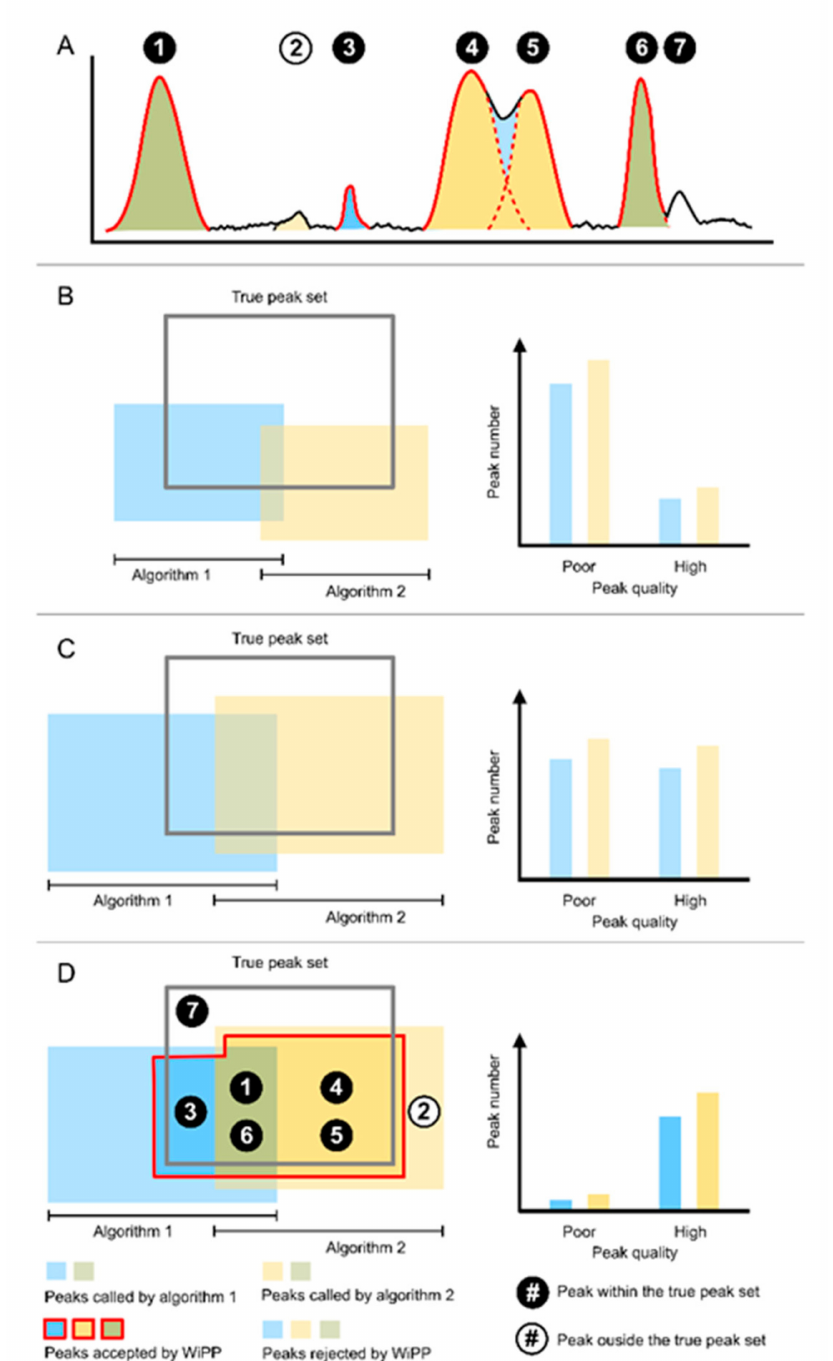
Figure 3. Schematic representation of the peak sets. ( A ) Chromatographic representation of peaks detected by the two peak picking algorithms accepted or rejected by WiPP. An individual ID is assigned to each peak. Peak 4 and 5 are erroneously detected by algorithm 1 as one single merged peak, hence the light blue colour between the distinct peaks properly detected by algorithm 2. ( B ) Peak called by peak picking algorithm 1 and 2 compared to the true peak set of a dataset before parameter optimisation. ( C ) Peak called by algorithm 1 and 2 after parameter optimisation. ( D ) Peaks accepted and rejected by WiPP compared to the true peak set. Circled numbers represent the peak ID from subfigure A and are placed in their respective regions in peak